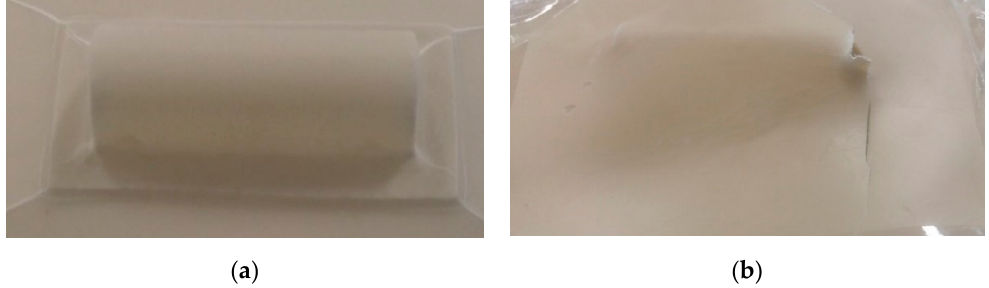
Figure 1. Thermoformed samples containing 60 wt.% starch ( a ) and 70 wt.% starch ( b ).